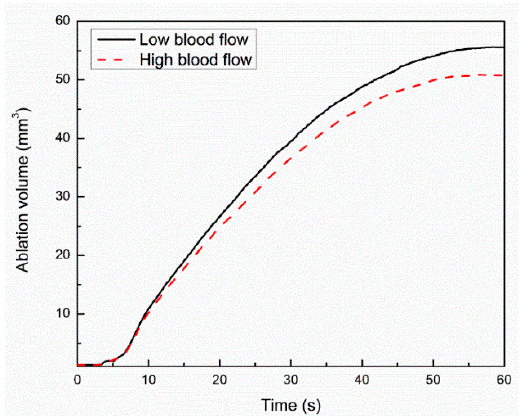
Figure 7. Temporal variation of ablation volume attained within the myocardium tissue with low and high blood flow conditions within the cardiac chamber.